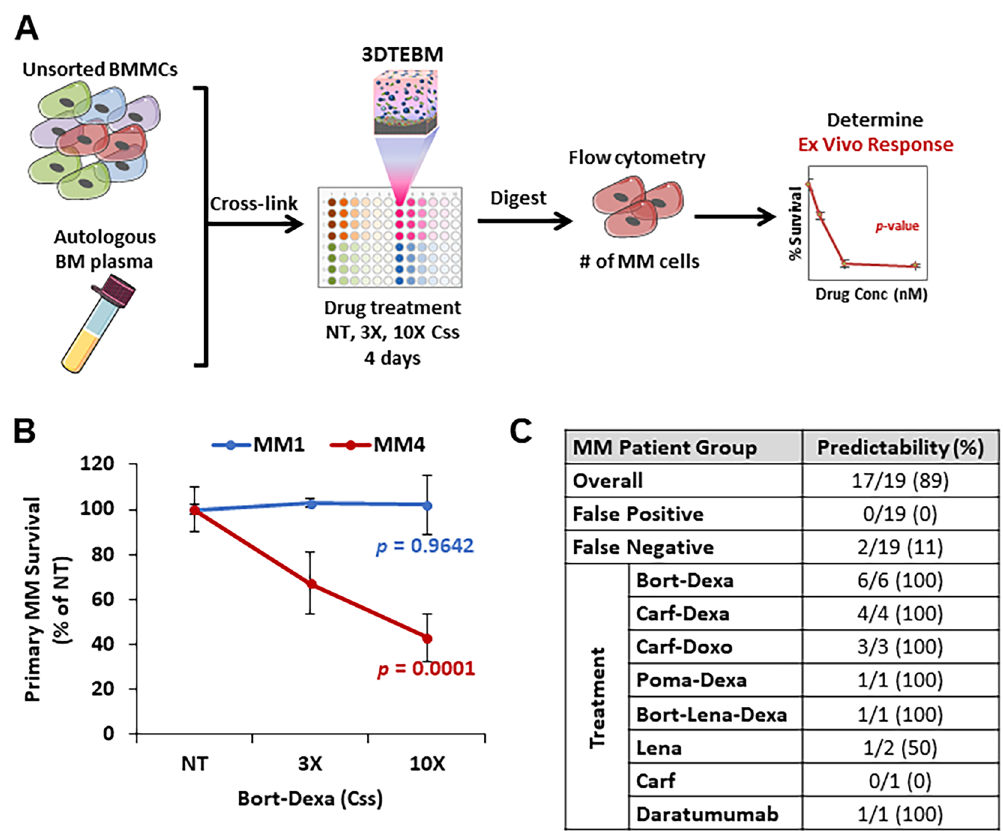
Figure 3. Retrospective predictability for MM patient cohort. ( A ) Schematic of experimental procedure for determining ex vivo response in 3DTEBM utilizing patient unsorted bone marrow mononuclear cells (BMMCs) and autologous BM plasma. ( B ) Example primary MM cell survival for a responsive and a non-responsive MM patient sample. Statistical significance is analyzed by single-factor ANOVA; responsive if p < 0.05. ( C ) Overall predictability of patient clinical response for each drug therapy using the 3DTEBM